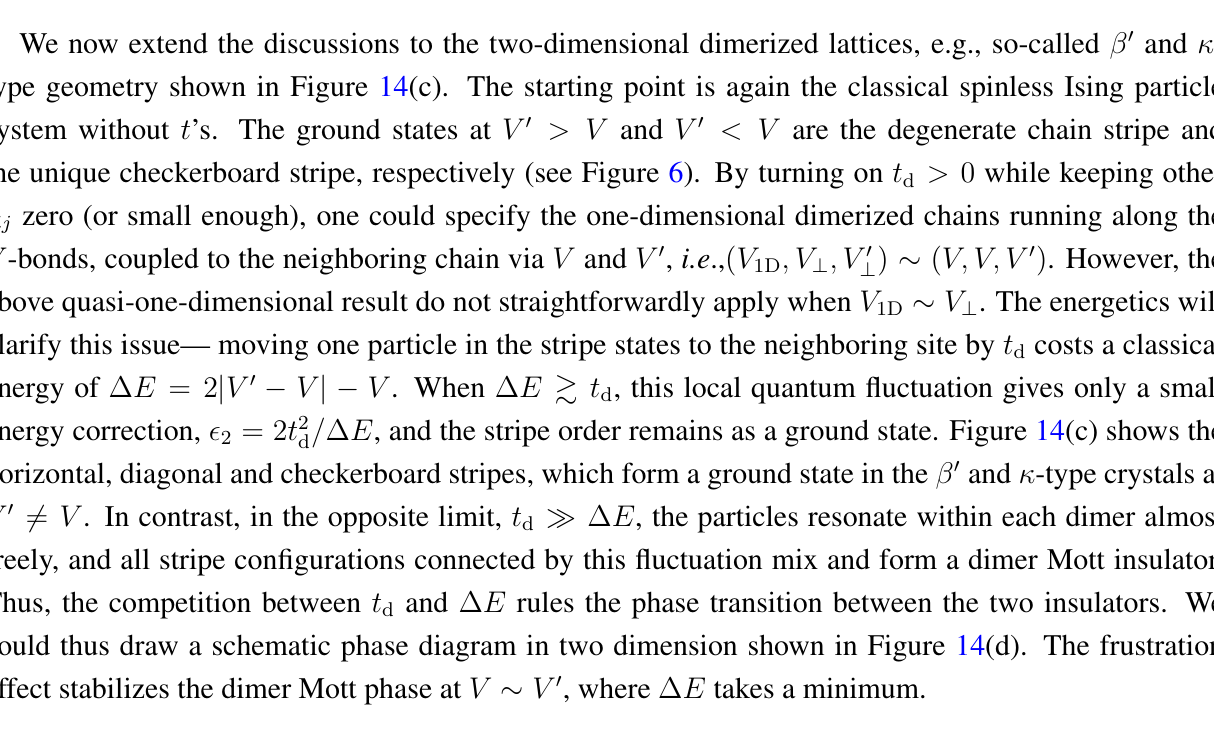
Figure 15. ( a ) Mapping of κ -type site-based lattice into a dimer-based anisotropic triangular lattice; ( b ) Configuration of charges on two adjacent dimers which have finite/zero exchange coupling J , and the texture of J eff for ordered and disordered charge configurations; ( c ) mn Schematic phase diagram of the dipole-spin model